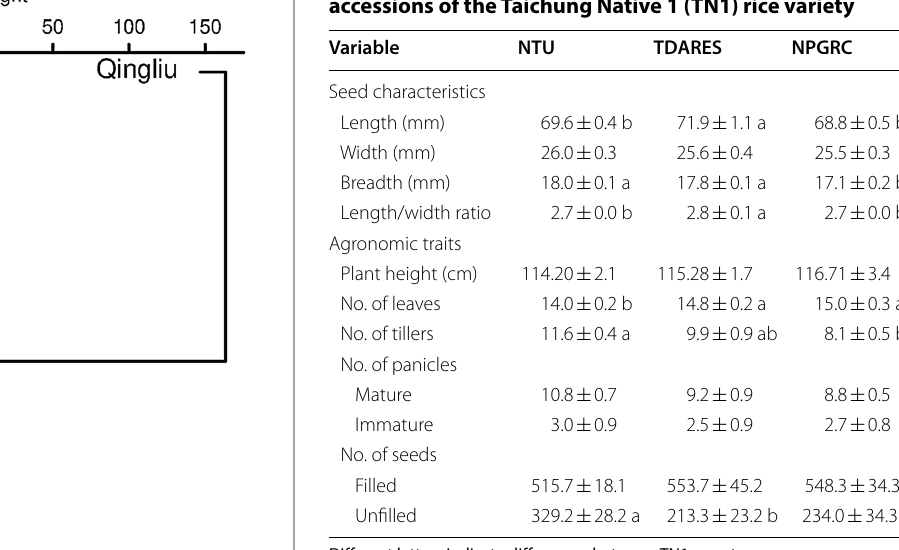
Table 1 Seed characteristics and agronomic traits of